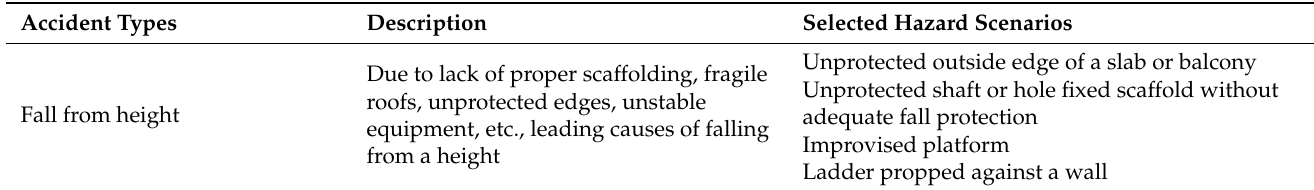
Table 2. Accident types and hazard scenarios identified in the typical building